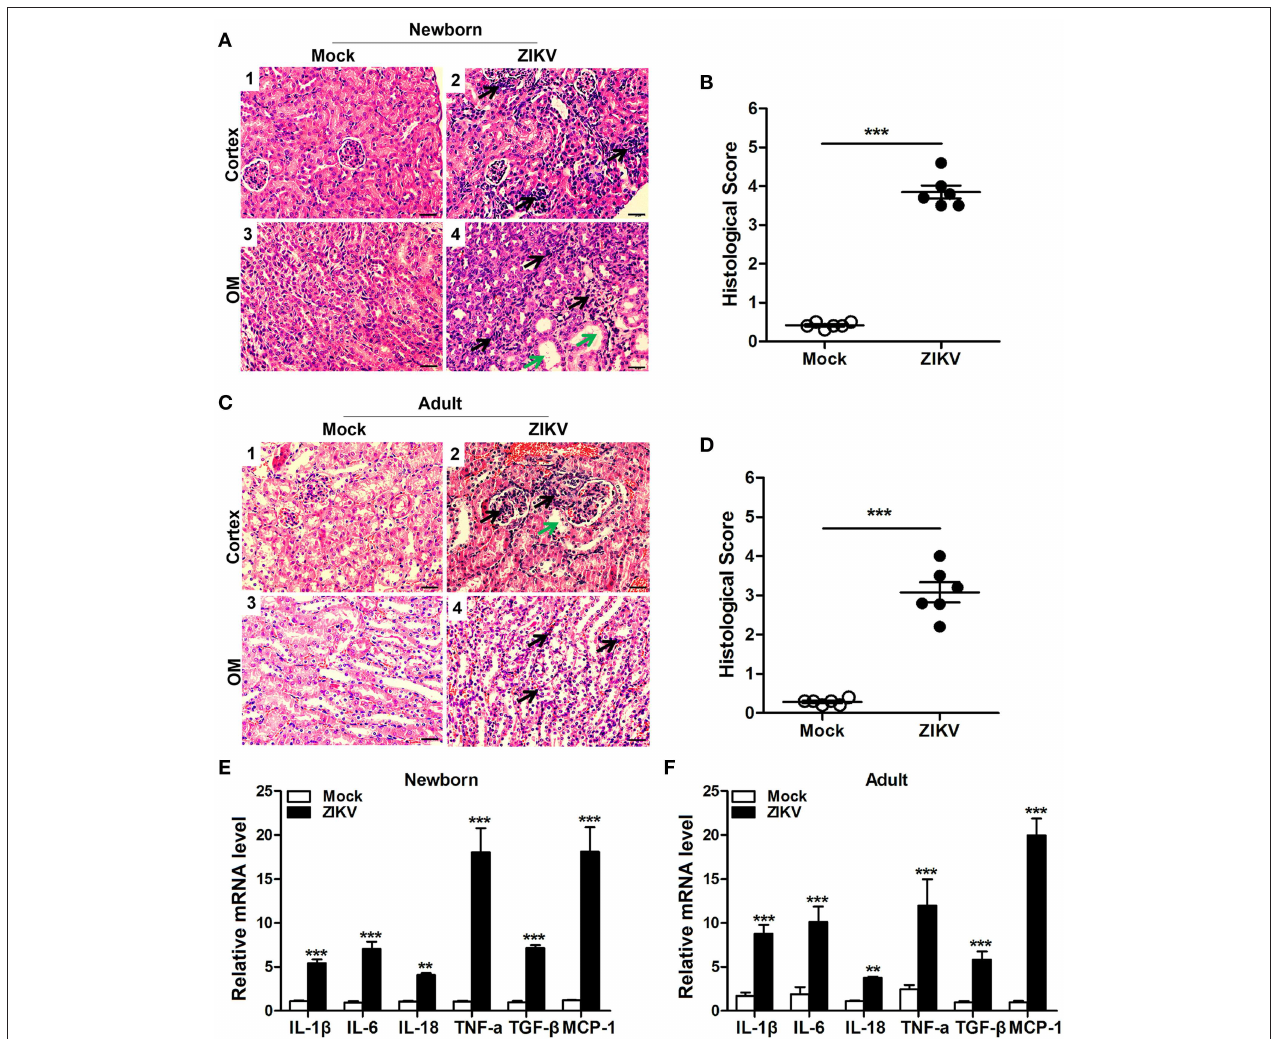
FIGURE 4 | ZIKV infection increased inflammatory cell infiltration and cytokines expression in the kidneys. (A–D) Morphological changes and quantification of histological damage in the cortex and outer medulla (OM) of newborn (A) and adult (C) mouse kidneys at 14 days post-infection. Tissue sections were stained with hematoxylin and eosin (H&E) (scale bar: 20 µ m); green arrows in the images indicated cell vacuolization; black arrows indicated inflammatory cell infiltration. (B–D) The histological score of newborn mice (B) and adult mice (D) were determined by tubular dilatation, vacuolization, tubular cell necrosis, loss of brush border, interstitial edema, and inflammatory cell infiltration. (E,F) The relative mRNA expression levels of IL-1 β , IL-6, IL-18, TNF- α , TGF- β , and MCP-1 in the kidneys of mock and ZIKV-infected newborn (E) and adult (F) mice at 7 days post-infection were determined by qRT-PCR. Data were presented as mean ± SEM ( n = 6), ** p < 0.01, *** p < 0.001 vs. mock